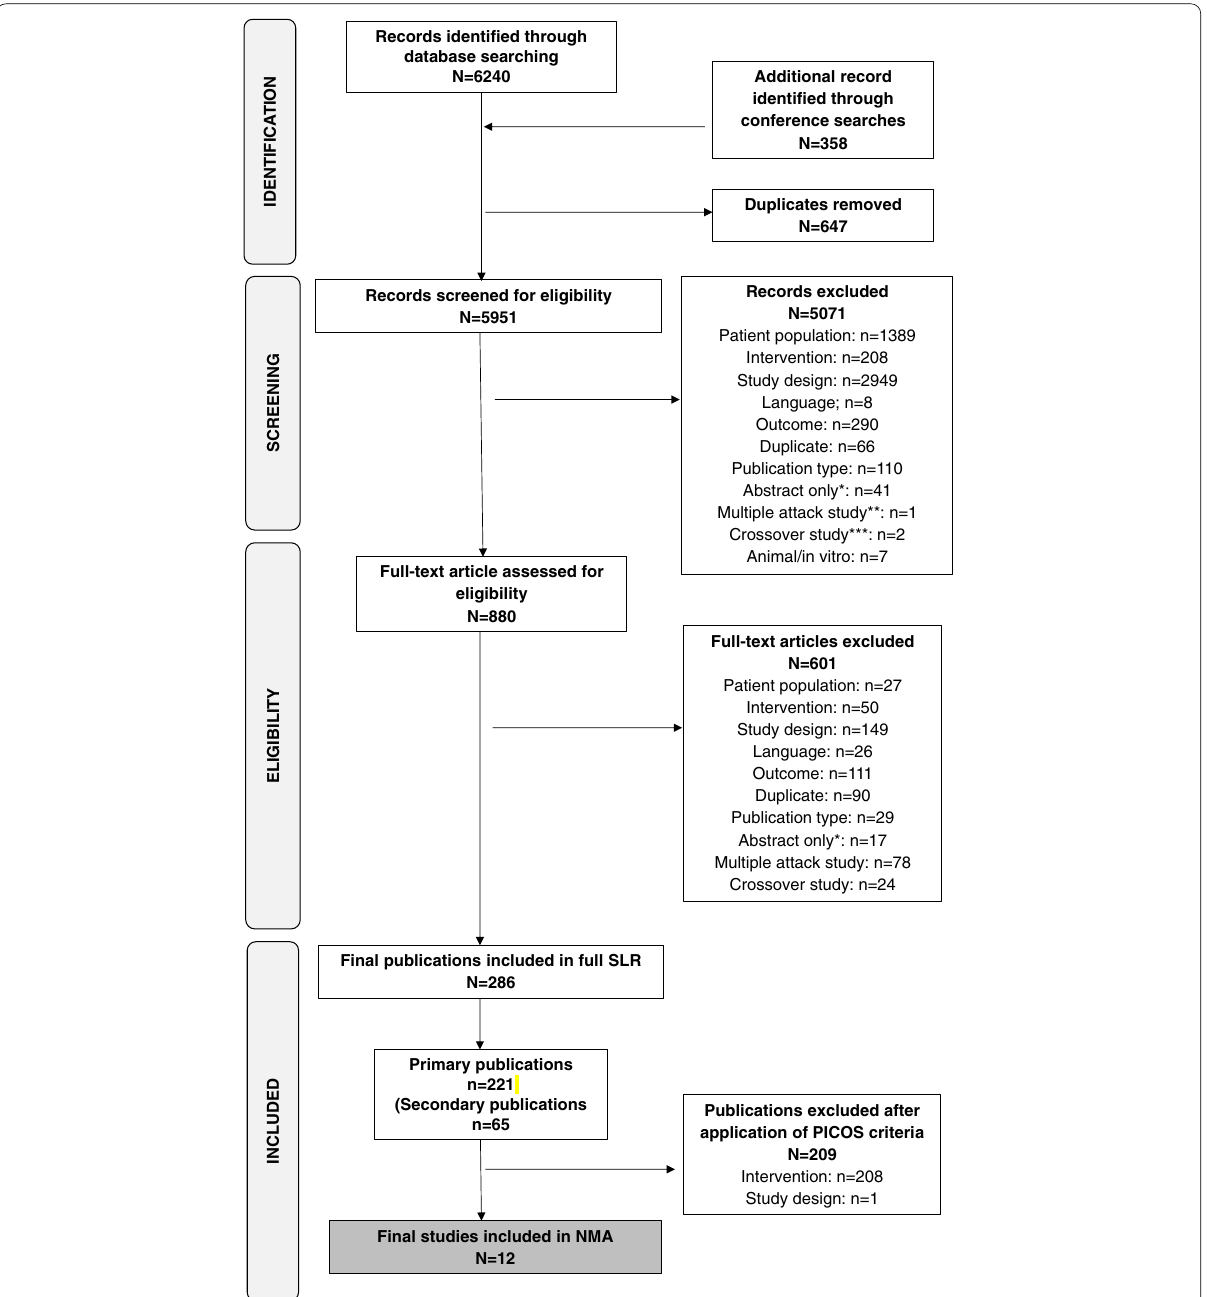
Fig. 1 PRISMA diagram representing the studies included in different stages of the SLR and current NMA. The SLR was first run in April 2018, and updated in May 2020 and December 2020. A more recent search of the literature, conducted on 31 August 2021, identified no additional studies. *Applies only to abstracts screened for full-text articles. A few prespecified specific conference abstracts and years were screened separately; therefore, conference abstracts and articles for which only information in abstract form were excluded from the main screening. **Abstract was a multiple attack study for which information was available only in aggregated form. ***Crossover study was a conference abstract for which aggregated data only were available. † No data were extracted from secondary publications. NMA, network meta-analysis; PICOS, population, intervention, comparator and outcome selection; PRISMA, Preferred Reporting Items for Systematic Reviews and Meta-Analyses; SLR, systematic literature